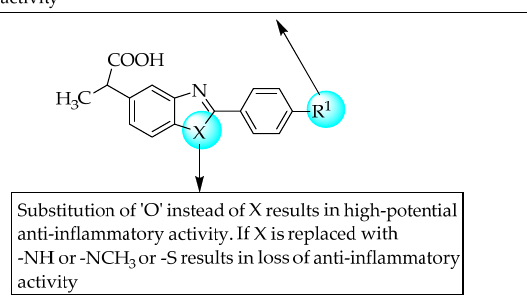
Figure 32. SARs of bio-isosteric replacement of benzoxazole.